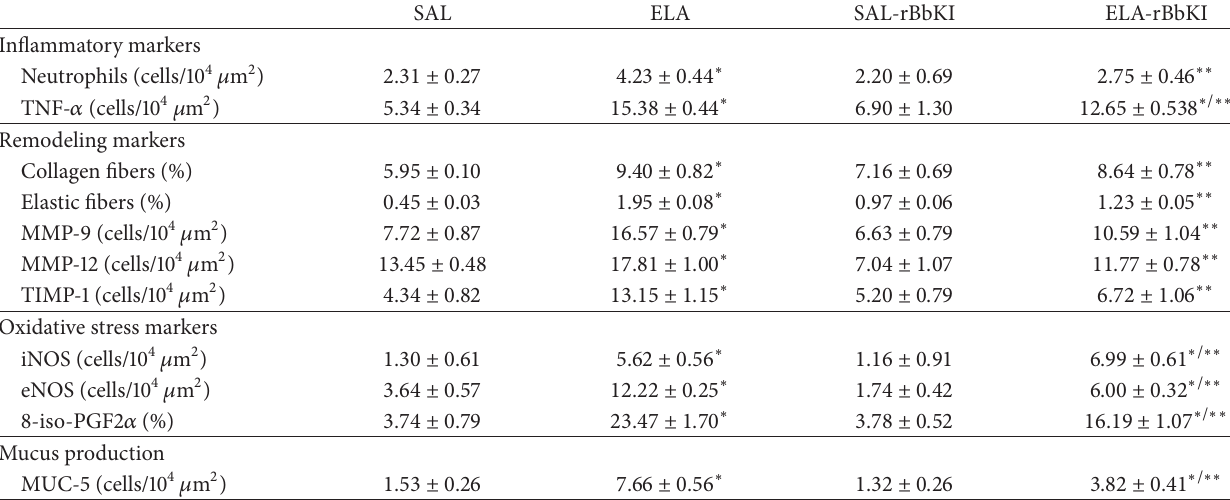
Table 3: Absolute values of the morphometric analysis for inflammatory, remodeling, and oxidative stress markers, in the airway walls. The neutrophils, TNF- 𝛼 , MMP-9, MMP-12, TIMP-1, iNOS, eNOS, and MUC-5 are expressed in positive cells/10 4 𝜇 m 2 . The collagen fiber, elastic fiber, and 8-iso-PGF2 𝛼 are expressed in percentage (%). ∗ 𝑃 < 0.05 , compared with the SAL and SAL-rBbKI groups; ∗∗ 𝑃 < 0.05 , compared with the ELA-rBbKI